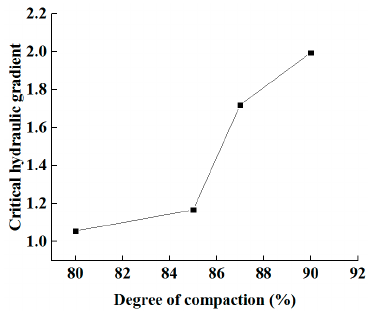
Figure 7. Critical hydraulic gradients for different degrees of compaction.